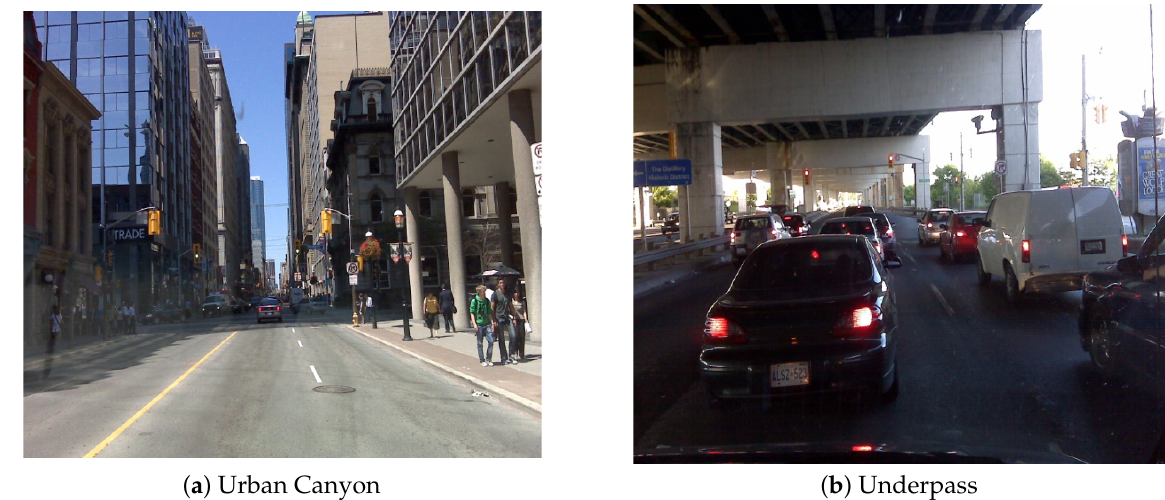
Figure 2. GNSS in challenging Fig. 2. GNSS in Challenging Environment